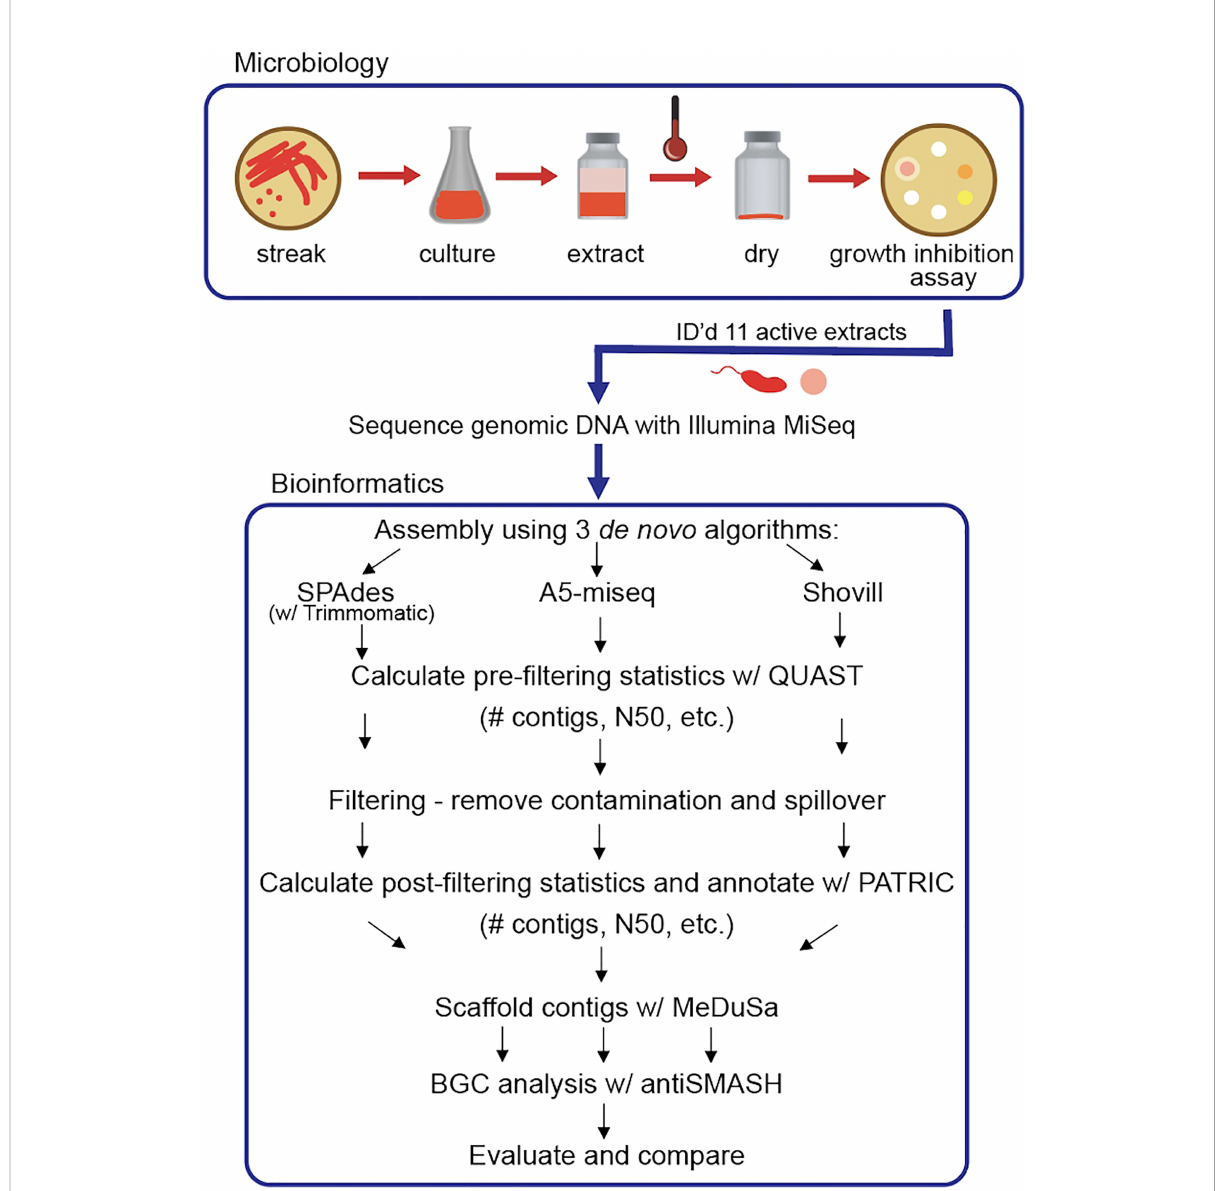
FIGURE 1 Schematic overview of research pipeline: microbiology procedures and experiments to identify strains producing extracts with inhibitory activity against M. tb and comparative bioinformatic analysis of three de novo assembly pipelines with evaluation parameters to optimize assembly completeness for genome mining. Note: Some symbols sourced from Integration and Application Network